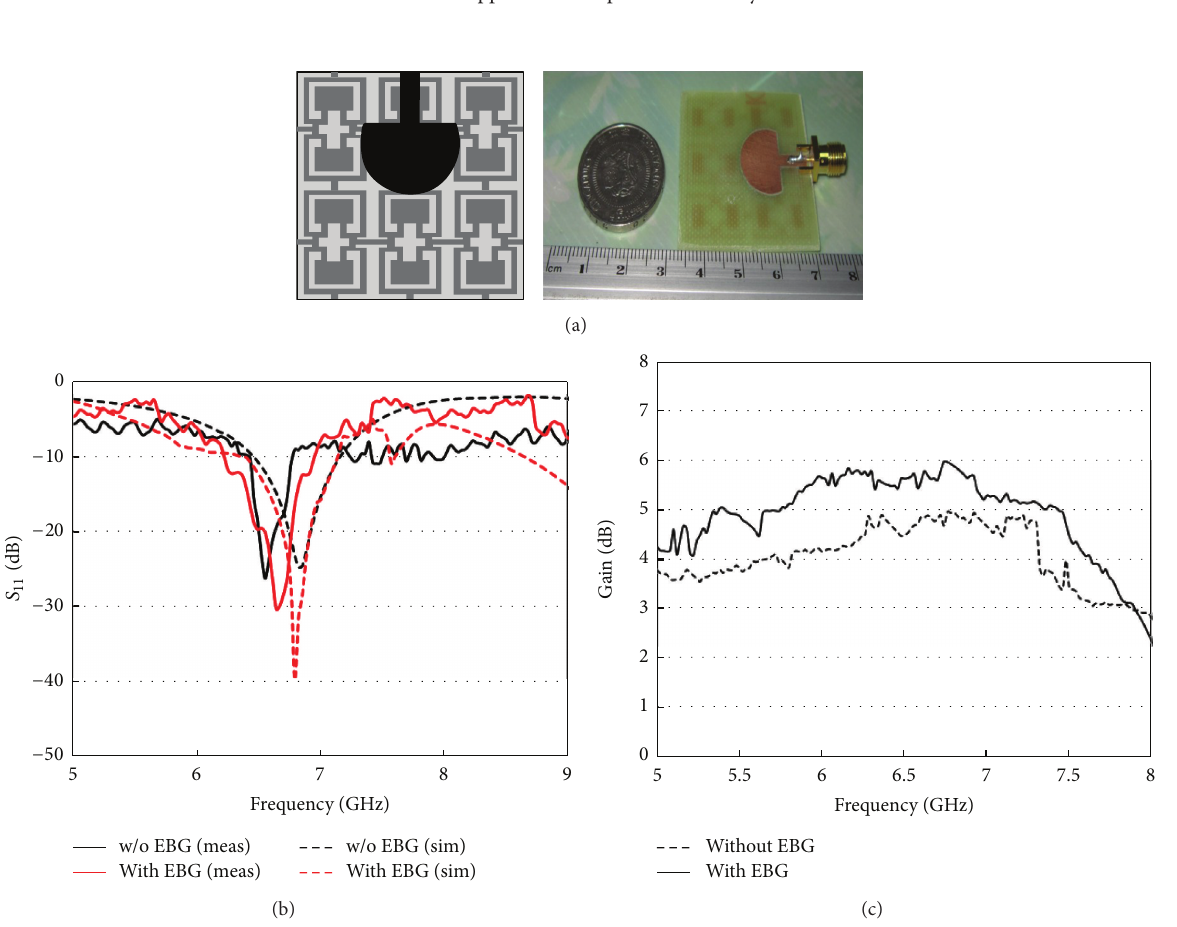
Figure 19: (a) An umbrella shape monopole with SRS-EBG as ground plane, (b) return loss characteristics, and (c) gain